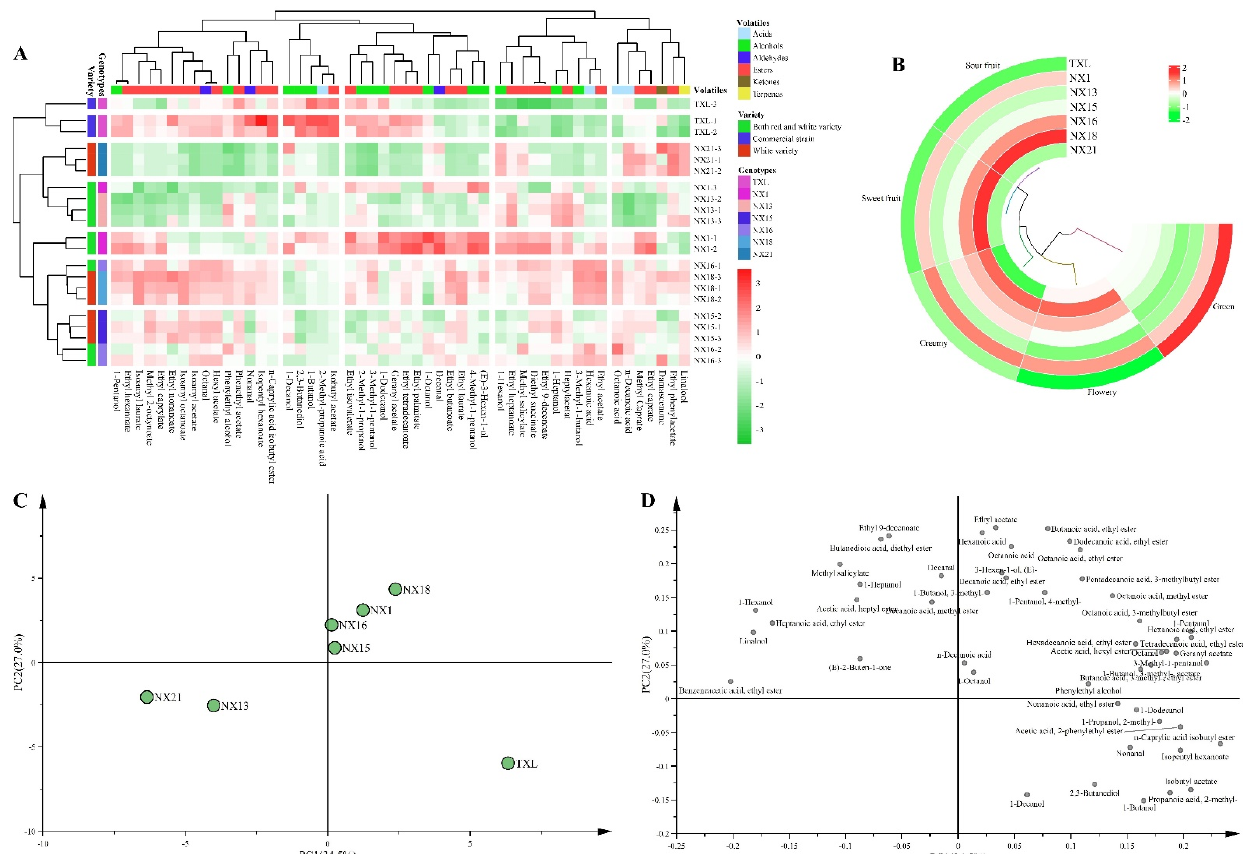
Figure 6. Volatiles profile in Chardonnay wine fermented by 6 indigenous S. cerevisiae strains with varying genotypes. ( A ): Heatmap analysis of volatile compounds in Chardonnay wines. ( B ): Aroma attributes of the Chardonnay wines. Principal component analysis (PCA) score ( C ) and loading ( D ) plots of the Chardonnay wines.